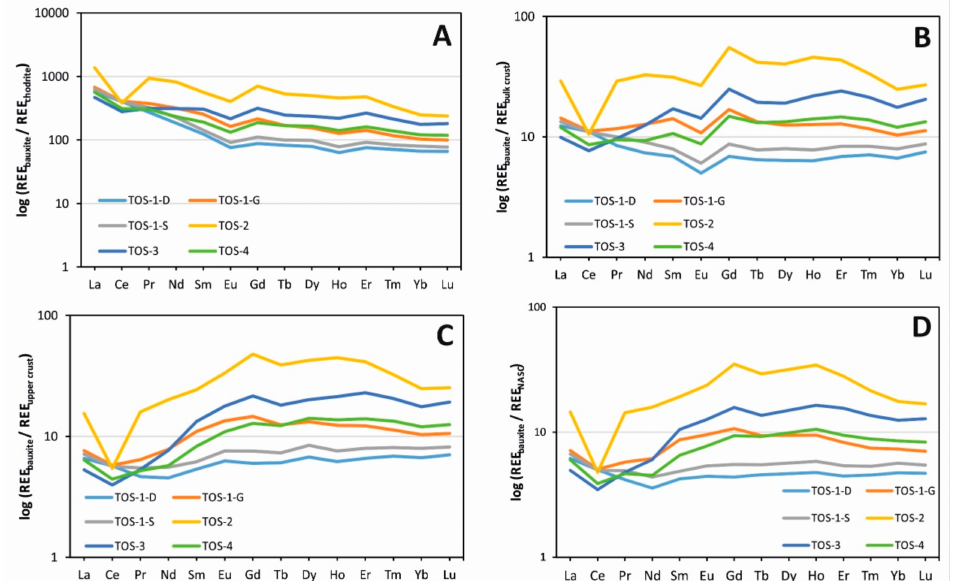
Figure 8. REE distribution in the samples of the Toši´ci-Duji´ci deposit: ( A ) Chondrite normalized REE patterns (chondrite data from [36]); ( B ) Bulk continental crust normalized REE patterns (bulk conti- nental crust data from [35]); ( C ) Upper-crust normalized REE patterns (upper crust data from [35]); ( D ) NASC normalized REE patterns (NASC data from [41]; value for Dy is interpolated due to missing data in the NASC